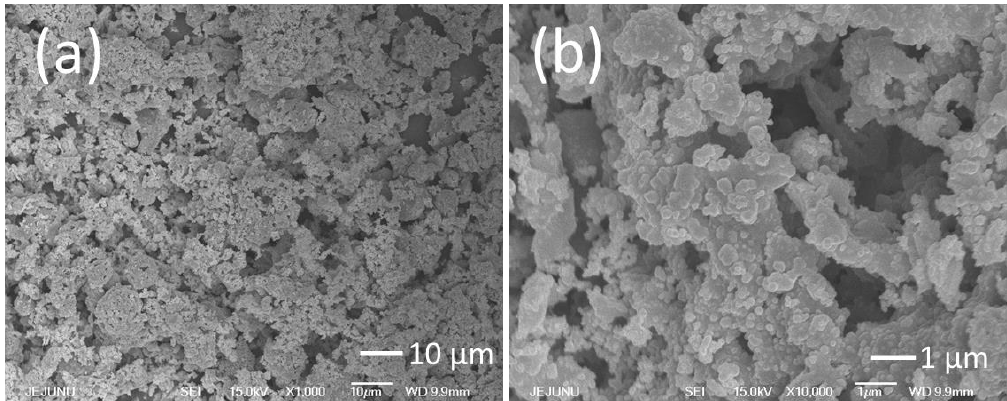
Figure 3. FE-SEM images of SrNiO 3 perovskite catalyst at low ( a ) and high magnifications ( b ).